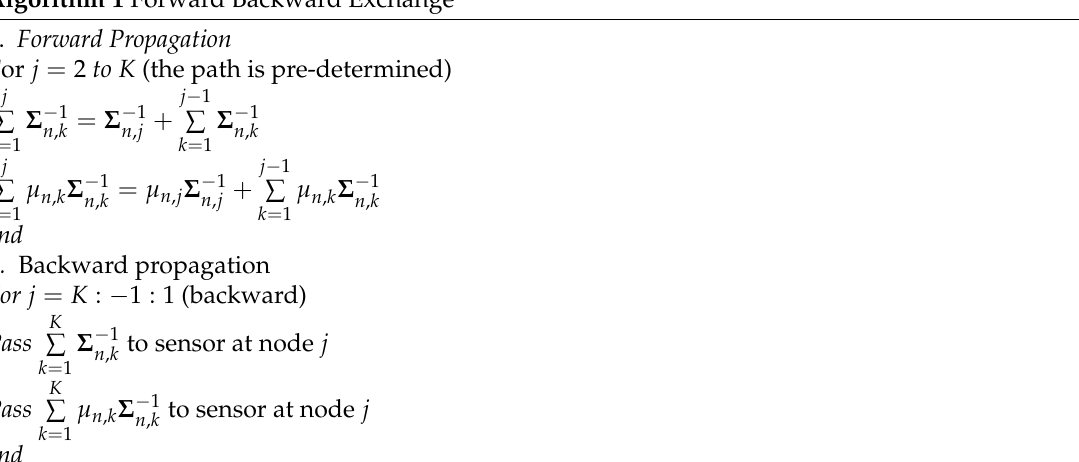
Algorithm 1 Forward Backward Exchange 1. Forward